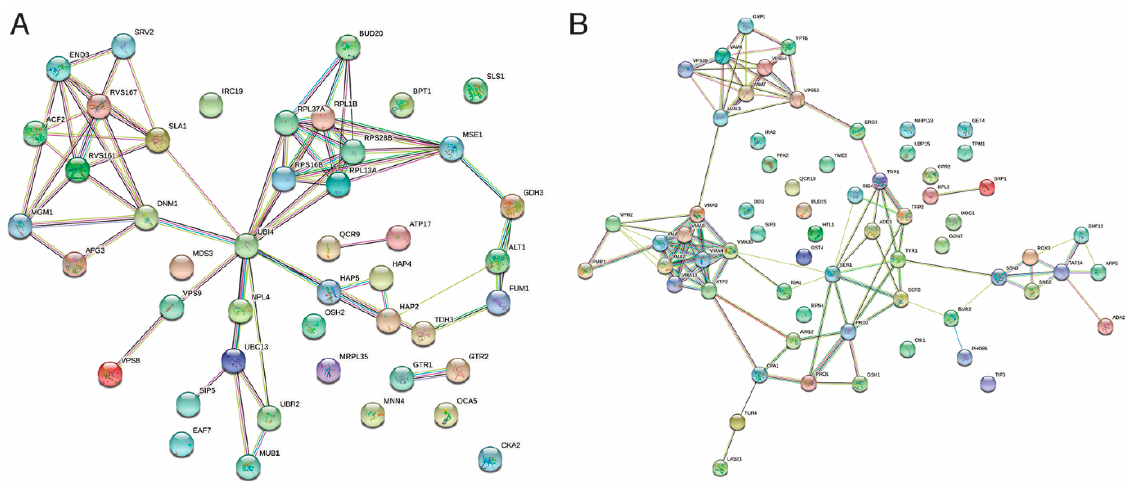
Figure 2. A clustering visualization of the 47 polygodial hyper-resistant ( A ) and 66 polygodial hypersensitive ( B ) strains using the STRING database. The colored circular nodes represent proteins while the edges joining the nodes represent protein–protein interactions, either established or predicted interactions.